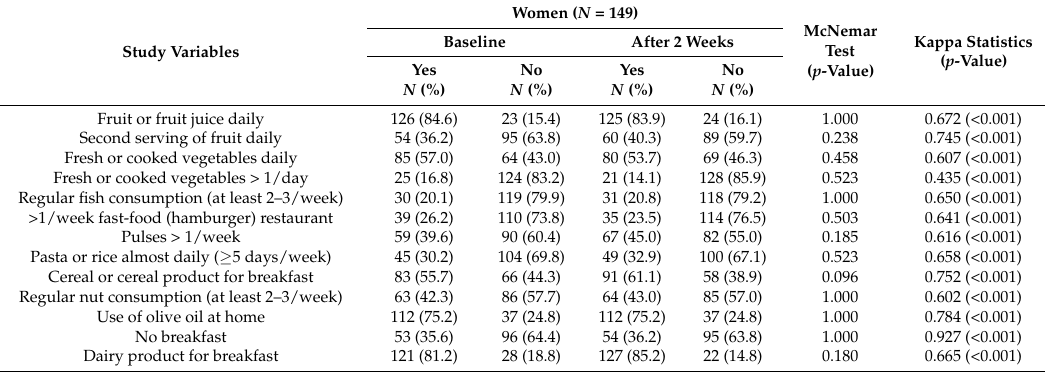
Table 4. Mediterranean Diet Quality Index statistics for women ( N =